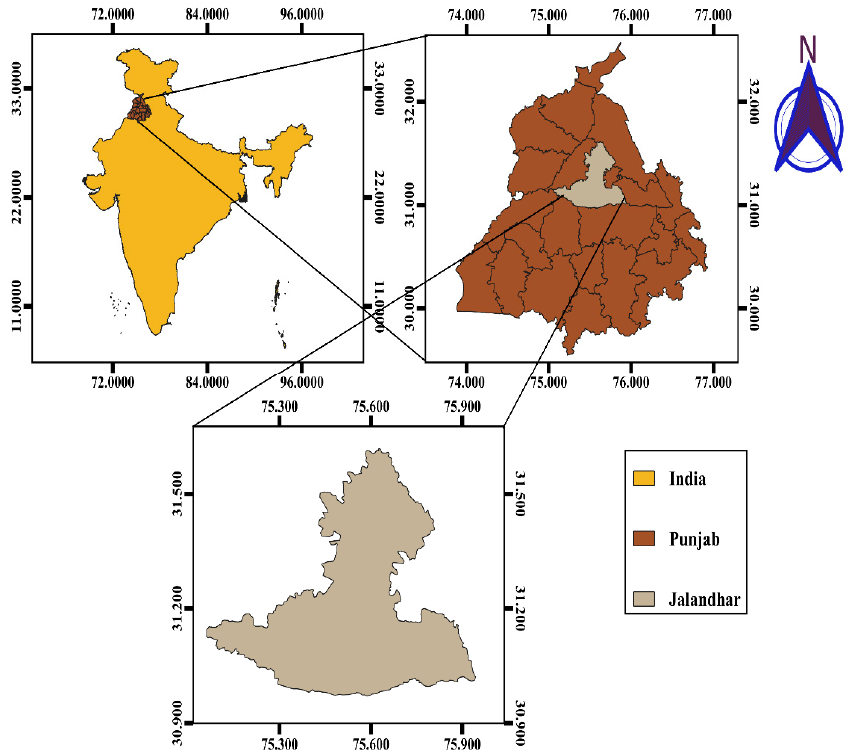
Figure 1. Study area showing different sites.